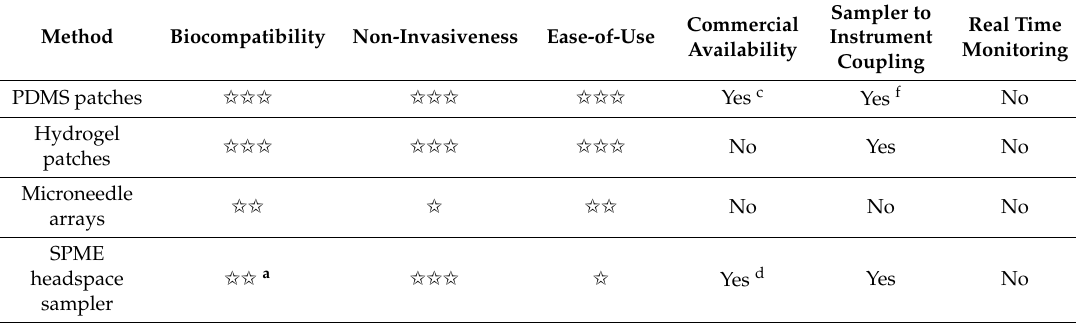
Table 3. Comparison of reviewed sampling methods (biocompatibility, non-invasiveness, and ease-of-use: ☆ low, ☆☆ medium, ☆☆☆ high).